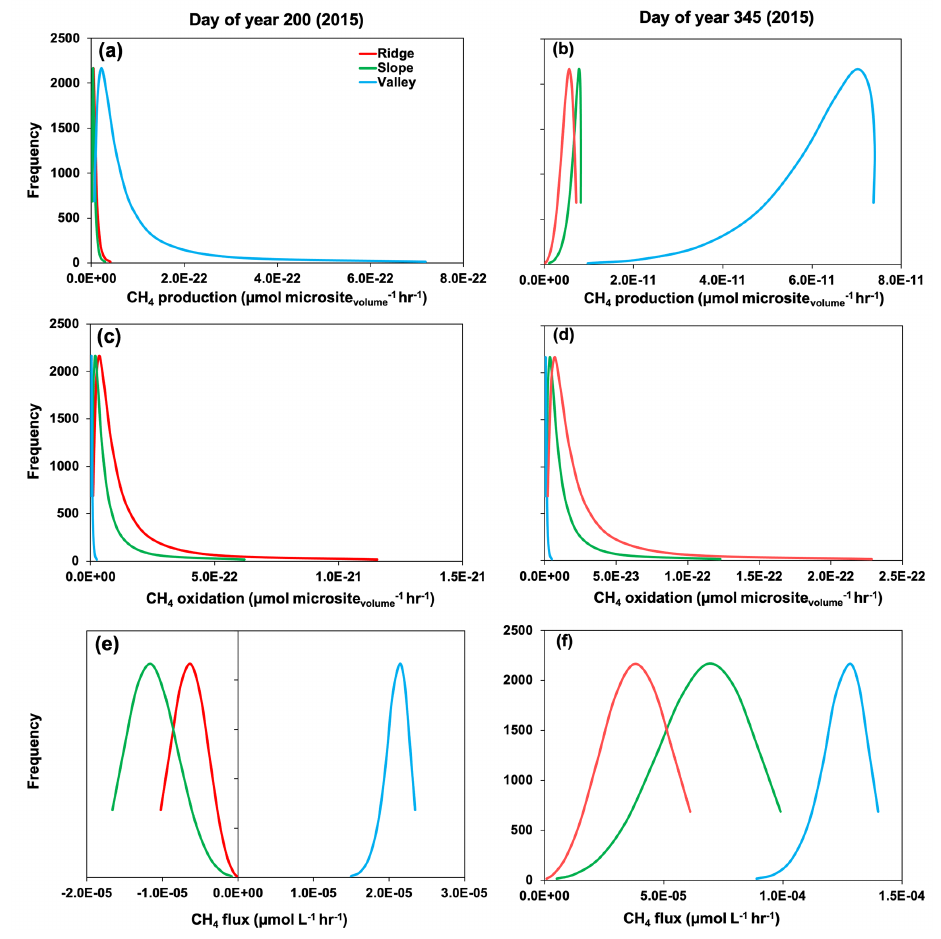
Figure 7. Rates of gross methane (CH 4 ) production (a, b) , oxidation (c, d) , and net flux (e, f) across simulated soil microsites. Day of year 200 and 345 represent drought and post-drought recovery, respectively (see medium gray and white shading in Fig.